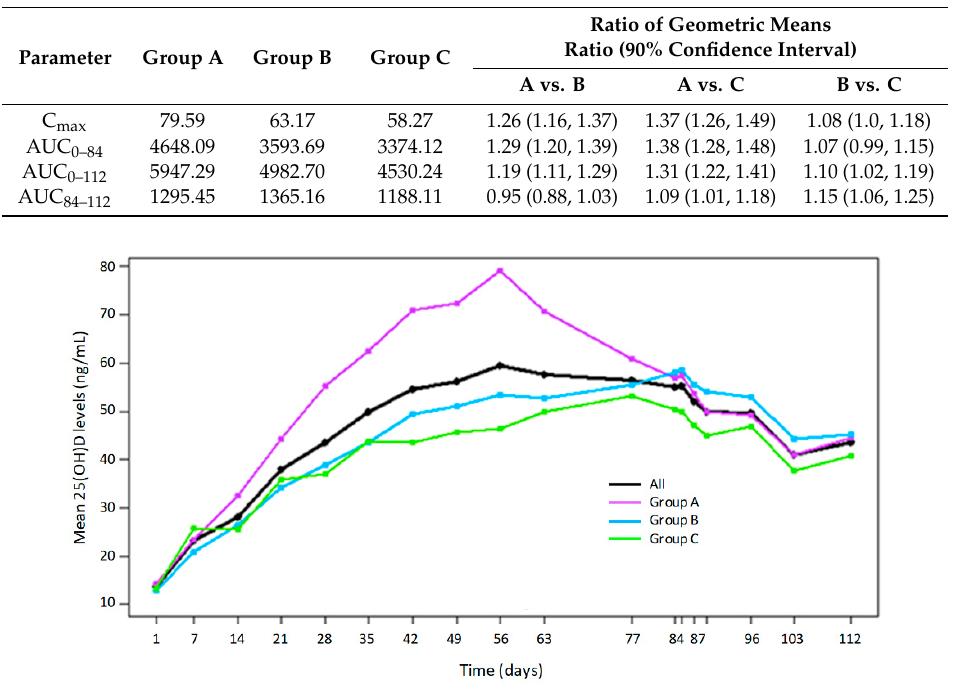
Figure 2. Serum 25 (OH)D levels in healthy participants treated with the three different dosing regimens of cholecalciferol over the study period. Group A; 10,000 International Units (IU) daily, Group B; 50,000 IU weekly and Group C; 100,000 IU bi-weekly doses of cholecalciferol. Twenty-five (OH)D plasma levels increased from an average baseline value of 13.5 ± 3.7 ng / Table 2. Pharmacokinetics parameters determined from the serum 25 (OH)D concentration.